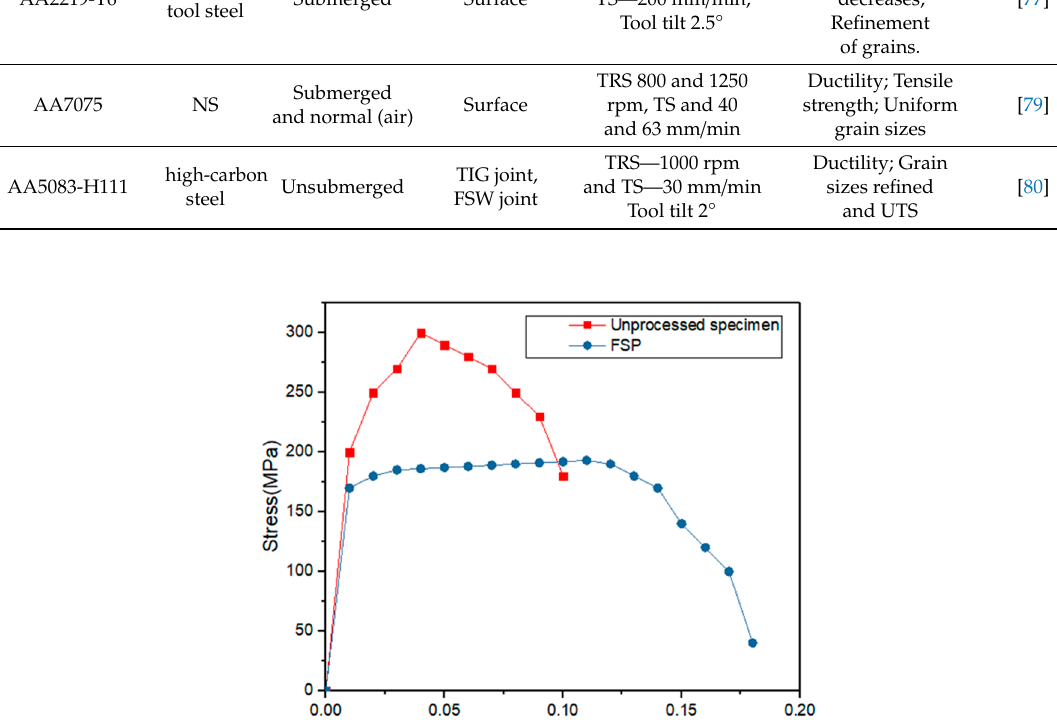
Table 4. Typical FSP tools. (PL—Pin length, PD—Pin diameter, SD—Shoulder diameter, SL— Shoulder length, PH—Pin height, NS—Not specified, SBPL—Square base pin length, CHL—Conical head length.).